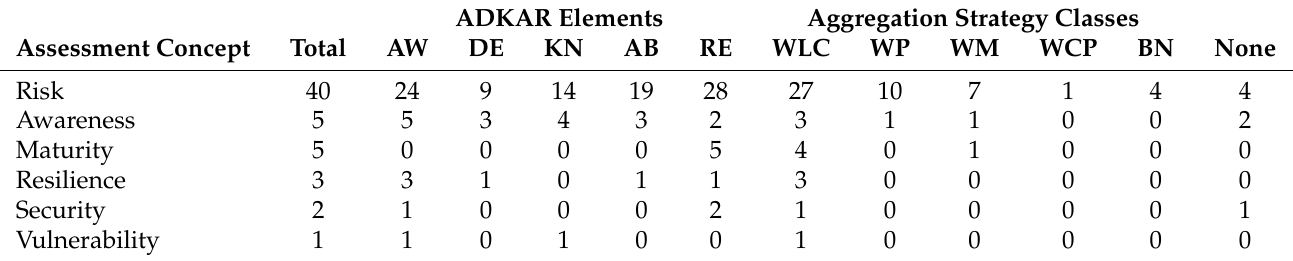
Table 6. The various security assessment concepts discussed in research, with an indication of the ADKAR elements covered and the aggregation strategies employed. Each paper should consider at least one ADKAR element. A paper may not aggregate at all, but could also employ several aggregation strategies. Reviews were not labelled with a specific assessment concept.